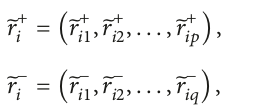
Algorithm III. TOPSIS-based method for obtaining order inducing vectors 𝜀